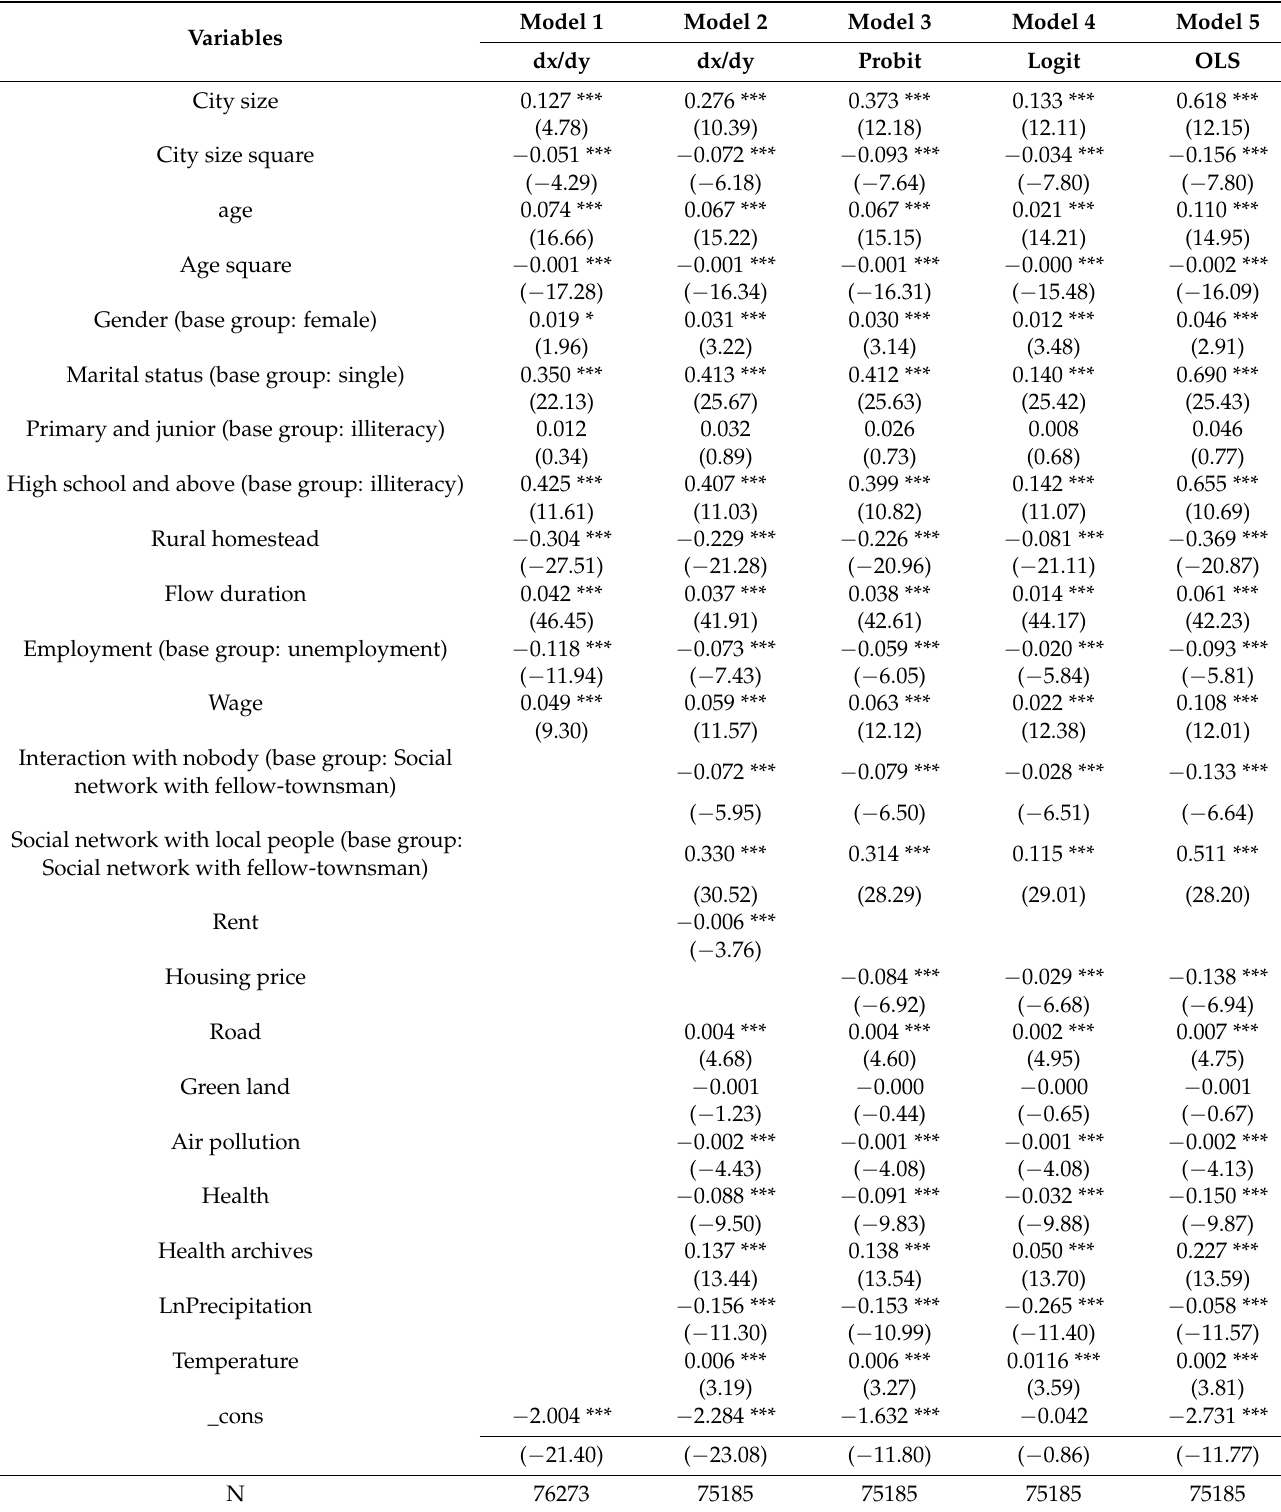
Table 3. The binary Probit regression of city size and migrants’ permanent settlement